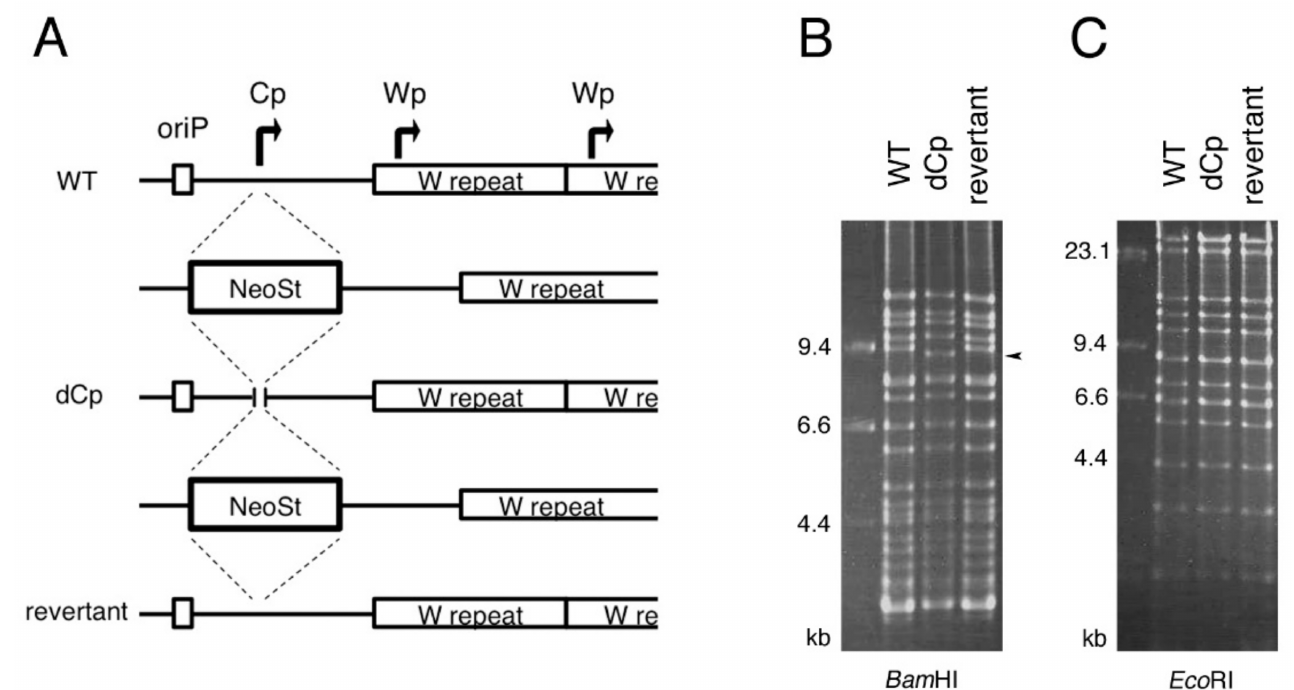
Figure 2. Construction of the C promoter deletion (dCp) and revertant (rev) EBV mutant constructs using the EBV-bacterial artificial chromosome (BAC) system. ( A ) Schematic diagram of the EBV-BAC recombination. The Neo/St cassette was inserted first in the Cp. Neo/St cassette was replaced with a Cp sequence with deletion from 11,145 to 11,476 (332 bp) of KC207813.1. The Neo/St cassette was reinserted again and then replaced with the wild-type (WT) Cp sequence to construct the rev virus. ( B , C ) Recombinant EBV-BAC DNA was digested by BamHI and EcoRI, and the products were examined by agarose gel electrophoresis. Note that the digested product near 9.4 kbp was shortened in the dCp virus (indicated by arrowhead), reflecting the